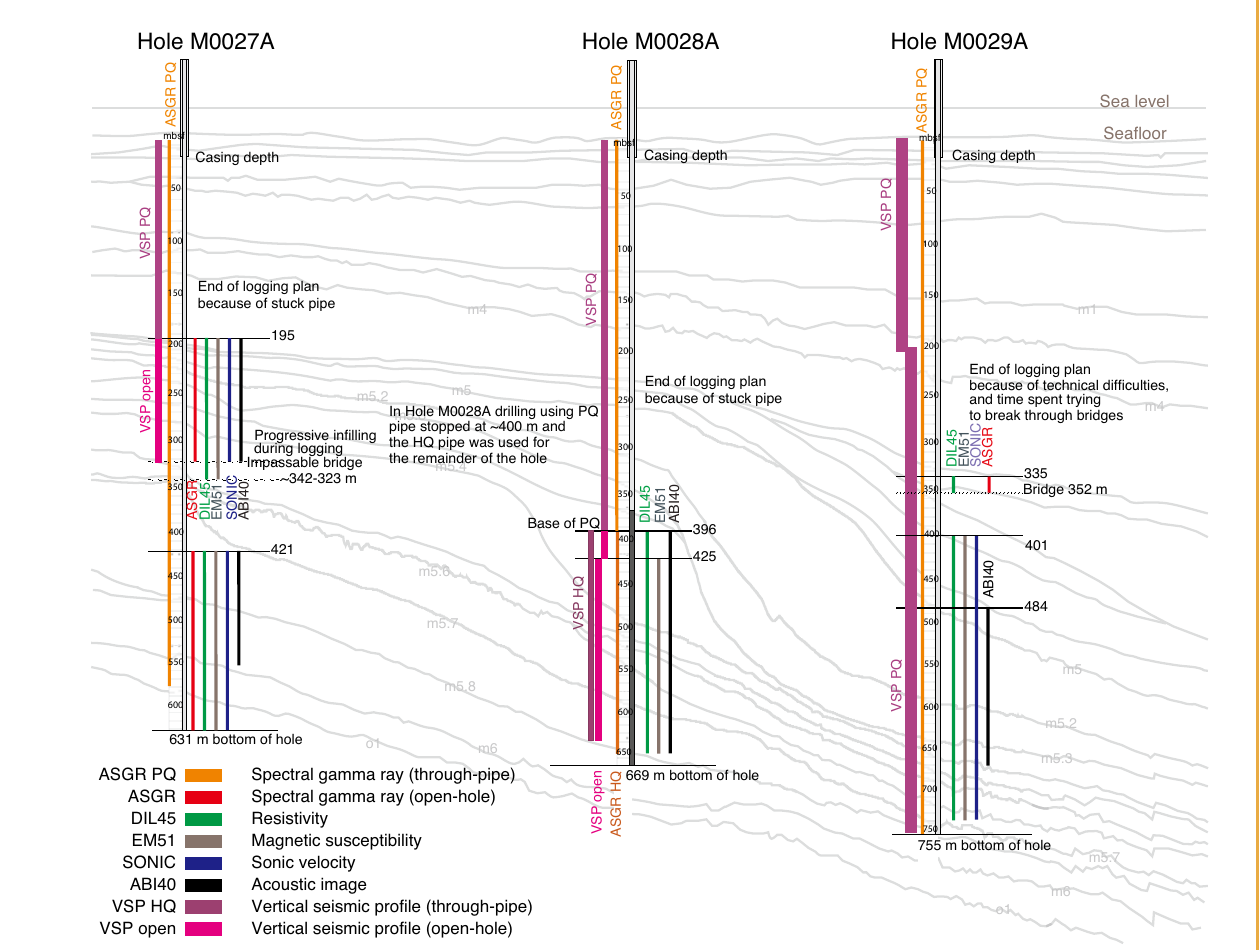
Figure 4. Graphic summary of downhole measurements from Expedition 313. Open-hole logging was planned and carried out in stages beginning with the lower section of each borehole. Vertical seismic profile (VSP) and through-pipe gamma logs are displayed to the left of the actual position of each borehole (gray column); open-hole logs are shown to the right. Vertical bars approximate positions of each measured interval. Gray reflectors in the background are the seismic sequence boundaries and other reflectors shown in Fig.